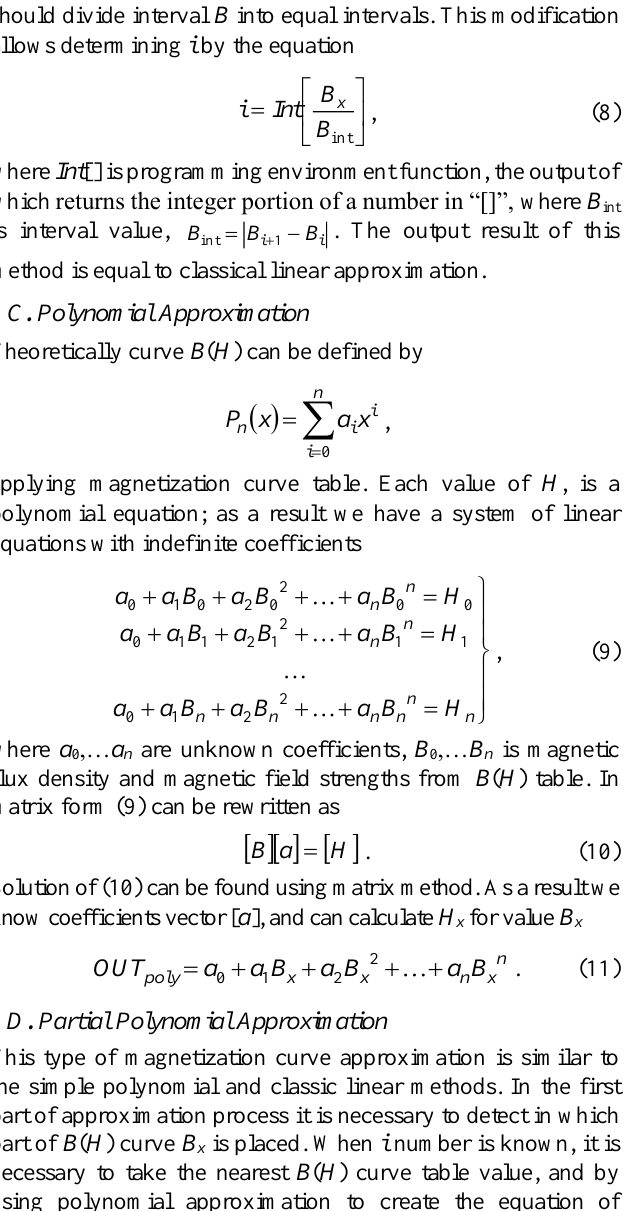
Fig. 9. Polynomial approximation with 3